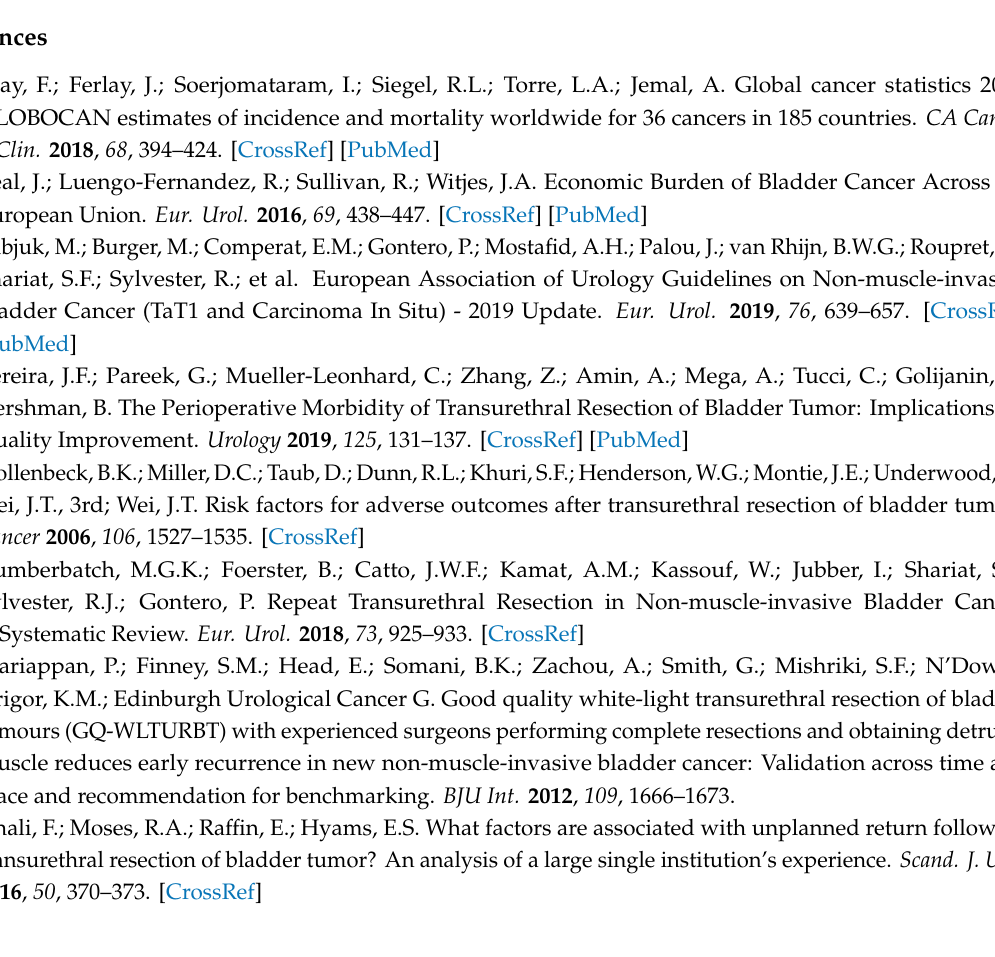
Figure S1: First-round distribution of the experts’ scores regarding the influence of the characteristics of the patient on the likelihood of complex TURBT; Figure S2: First-round distribution of the experts’ scores regarding the influence of the characteristics of the tumour on the likelihood of complex TURBT; Figure S3: First-round distribution of the experts’ scores regarding the influence on the likelihood of complex TURBT of bladder characteristics and access; Figure S4: First-round distribution of the experts’ scores regarding the influence of the surgical environment on the risk of TURBT or En-Bloc resection resulting in either three situations: incomplete resection according to the operator, prolonged surgery ( > 1 h) or significant intra- (bleeding that requires transfusion, laparotomy) or postoperative complications (Clavien-Dindo Grade III and higher); Table S1: Articles (English language, 4 / 2009-4 / 2019) found relevant to the definition of complexity in transurethral resection of bladder tumours; Table S2: 150 scenarios constructed for univariate and multivariate analyses of clinical features in relation to